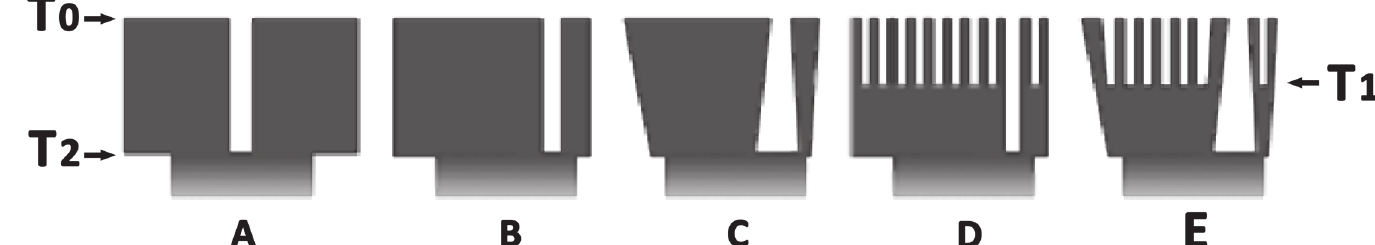
Fig 1. Demographic models used for the coalescent simulations: A — population split at T 2 with two derived populations of the same size; B — population split at T 2 with two derived populations with ratio between their effective population sizes (N EF ) equal to 0.15; C — population split at T 2 with two derived populations with the ratio between their N EF s equal to 0.06 at T 2 and 0.15 presently (T 0 ); D — same as model B, but with population substructure arising at T 1 in both derived populations; E — same as model C, but with population substructure arising at T 1 in both derived populations. The number of demes depicted does not correspond to the actual simulations. For further details see methods